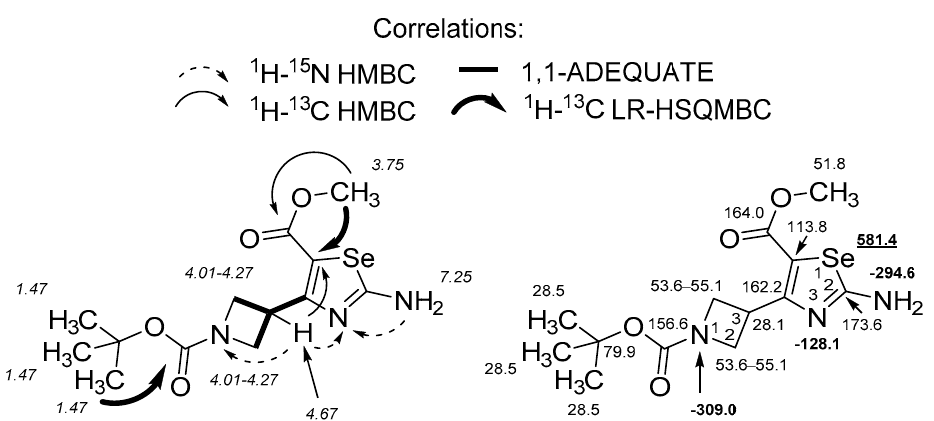
Figure 3. Relevant 1,1-ADEQUATE, 1 H- 13 C HMBC, 1 H- 15 N HMBC, 1 H- 13 C LR-HSQMBC correla- tions and 1 H NMR (in italics), 15 N NMR (in bold), 77 Se (in bold, underlined) and 13 C-NMR chemical shifts of compound 4 .